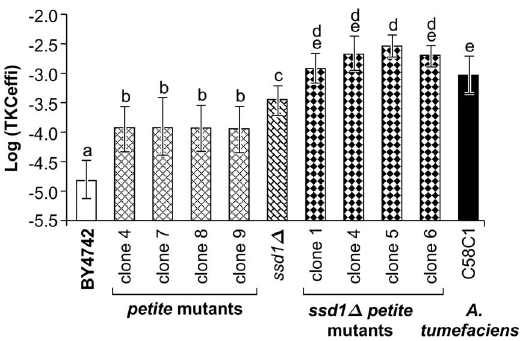
Figure 4. Efficiency of DNA transfer by TKC between a bacterial strain and yeast can be comparable to that for conjugation between two bacterial strains. TKC reactions were set up between Escherichia coli HB101 and Saccharomyces cerevisiae parental strain BY4742, or its petite mutants (clones 4–9), or a SSD1 deletion mutant ( ssd1 D ), or petite mutants of the SSD1 deletion mutant (clones 1–6). The DNA transfer efficiencies of the above TKC were compared with conjugation between the same strain of Escherichia coli HB101 and Agrobacterium tumefaciens C58C1. Data are represented as mean 6 SD (n=15 in BY4742, ssd1 D and C58C1, n=9 in others). Letters above the bars indicate significant differences at p , 0.05 (Holm’s test). HB101 (pRH210, pAY205) was used as the